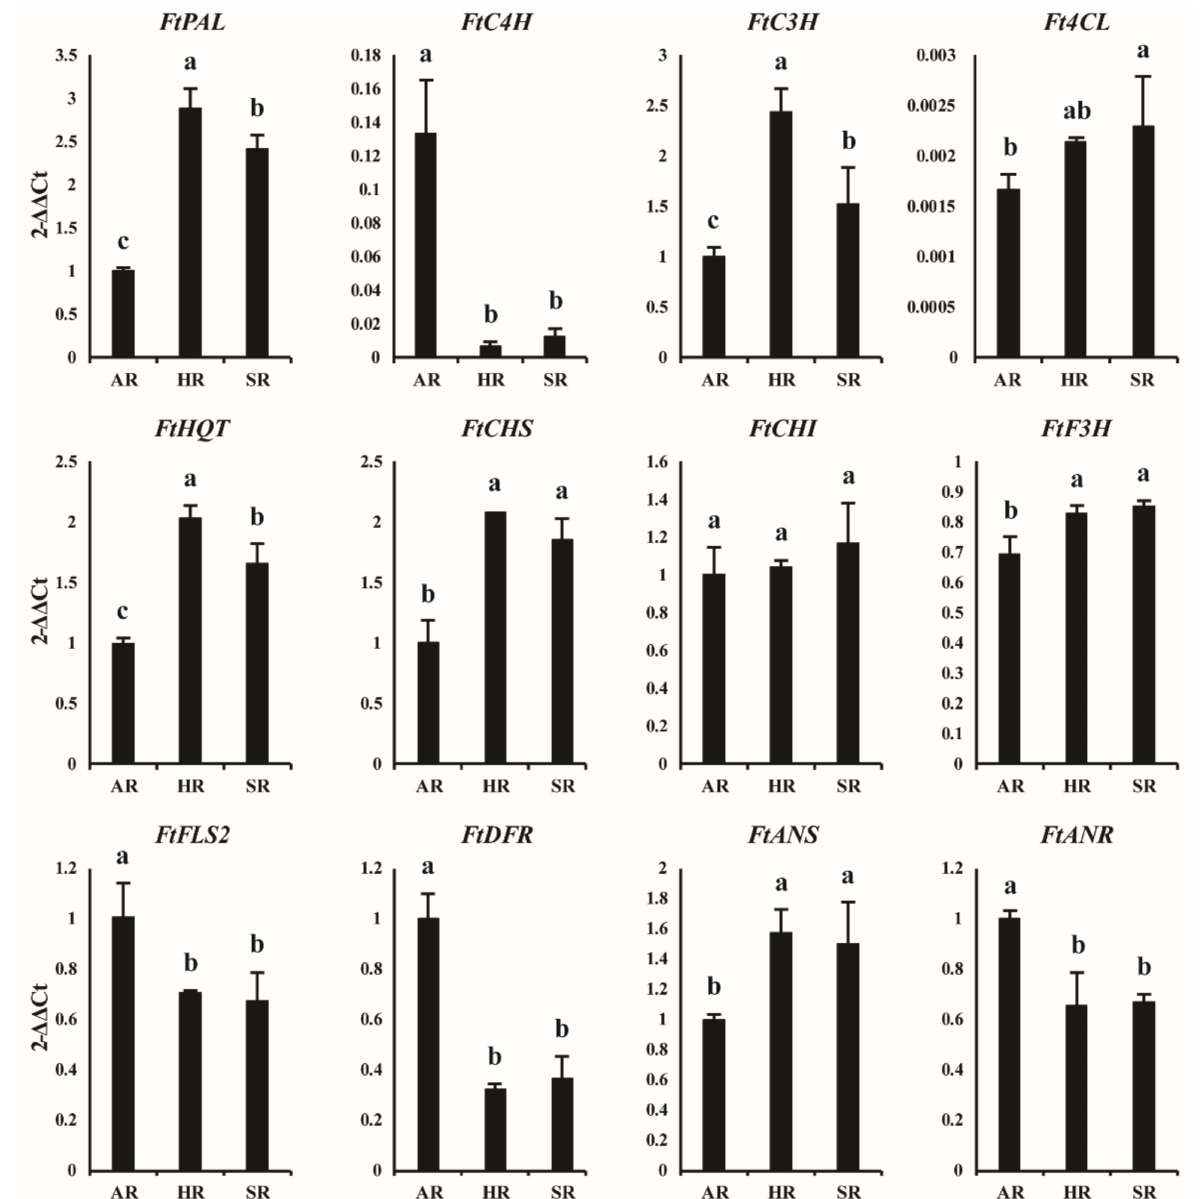
Figure 3. The gene expression profiles of the adventitious root (AR), hairy root (HR), and seedling root (SR) of F. tataricum . Values followed by different letters within a column indicate a significant difference ( p < 0.05) between areas for that parameter using DMRT ( n ≥ 5, mean ±